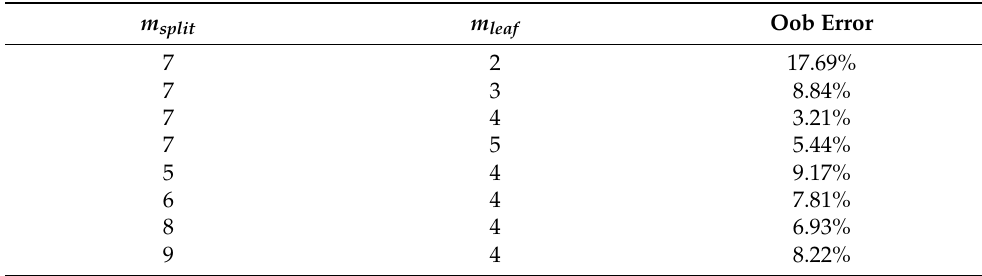
Table 1. Parameter Optimization ( m split and m leaf ).